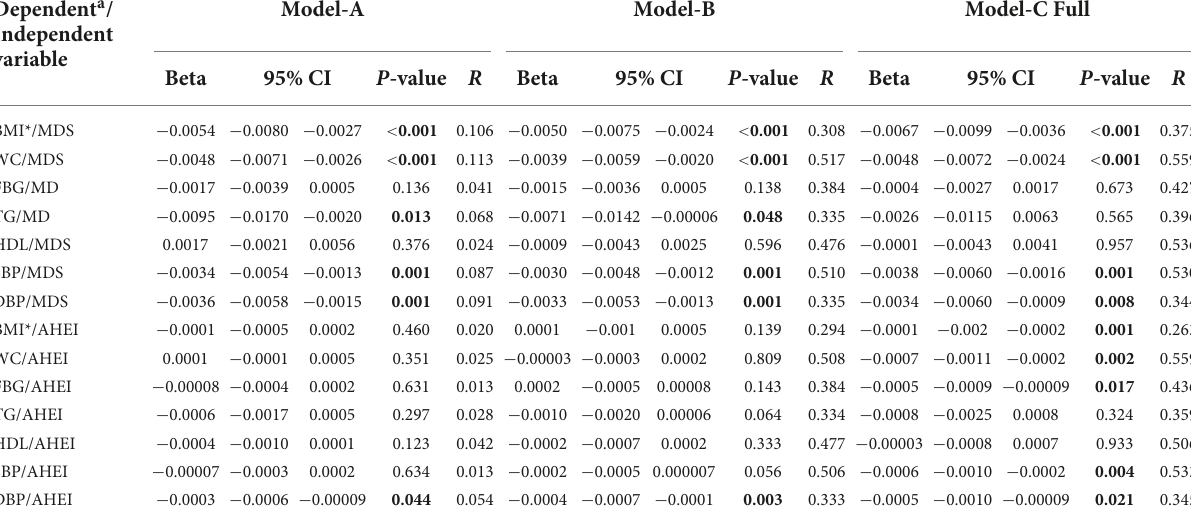
TABLE 5 Association of the dietary indices MDS and AHEI with MetS components, as derived by linear regression (beta non-standardized, 95% CI, P -value**, and strength of linear association